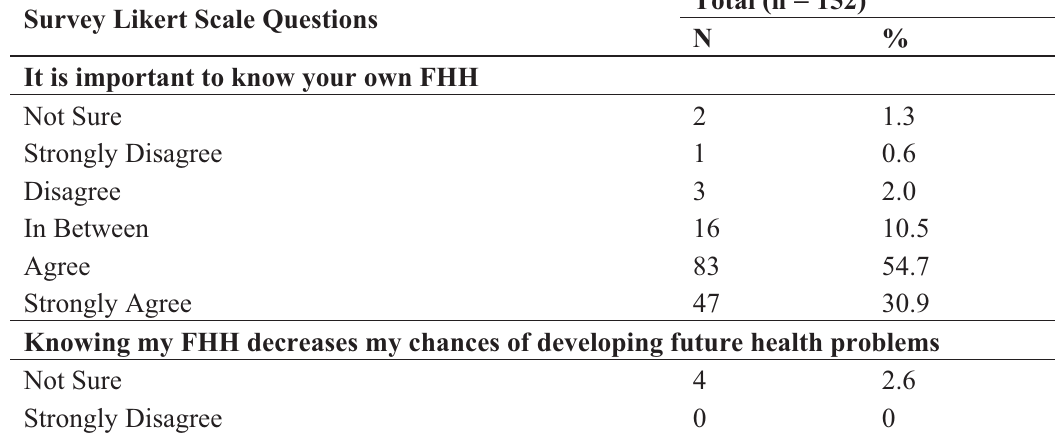
Table 2. Descriptive statistics of participants’ perceptions resulting from the intervention (n =